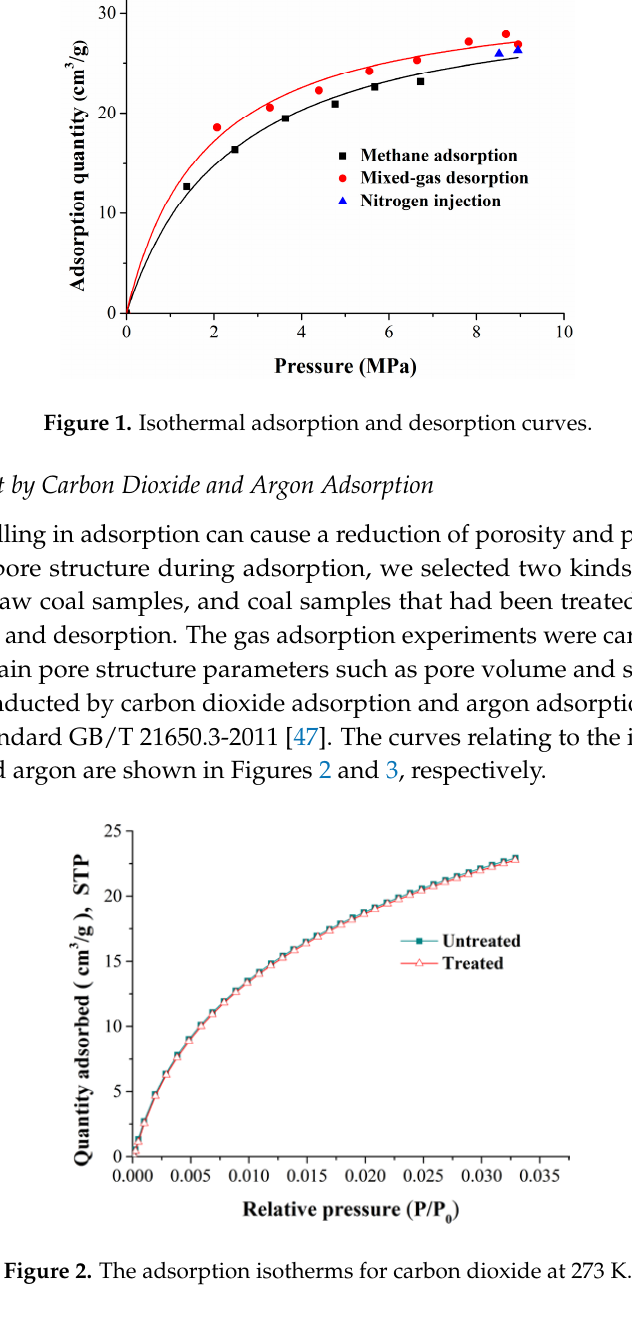
Figure 3. The adsorption isotherms for argon at 87 K. From Figure 2, the adsorption curves of carbon dioxide in ice water (273 K) for the untreated and treated coal samples were basically the same. Figure 3 shows that the adsorption curve of argon decreased slightly at 87 K for the treated coal sample, which shows that the pore structure of the coal samples has changed. 4. Deformation Characteristics of the Coal Matrix 4.1. Deformation of the Coal Matrix at the Methane Adsorption Stage The experimental results of the methane adsorption stage were substituted into Equation (6), which was used to obtain the coal matrix deformation amount, the results are shown in Table 2. Table 2. The coal matrix deformation amount and deformation rate at the methane adsorption stage. Serial Number